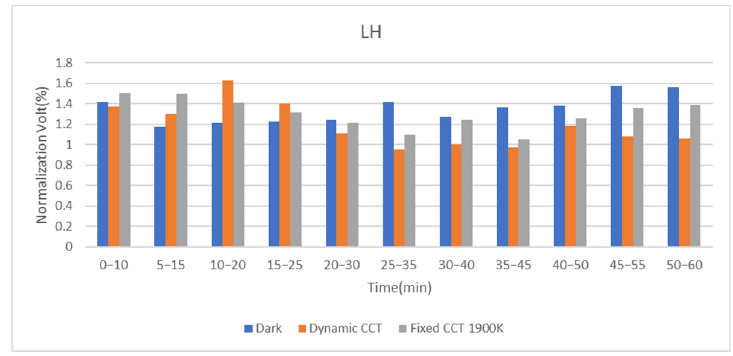
Figure 19. LH analysis.